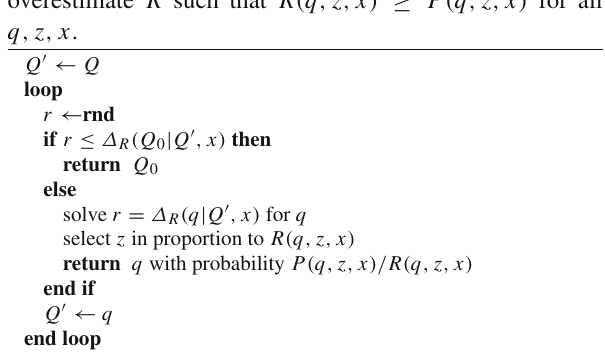
Algorithm 1 The Sudakov veto algorithm, defined using an